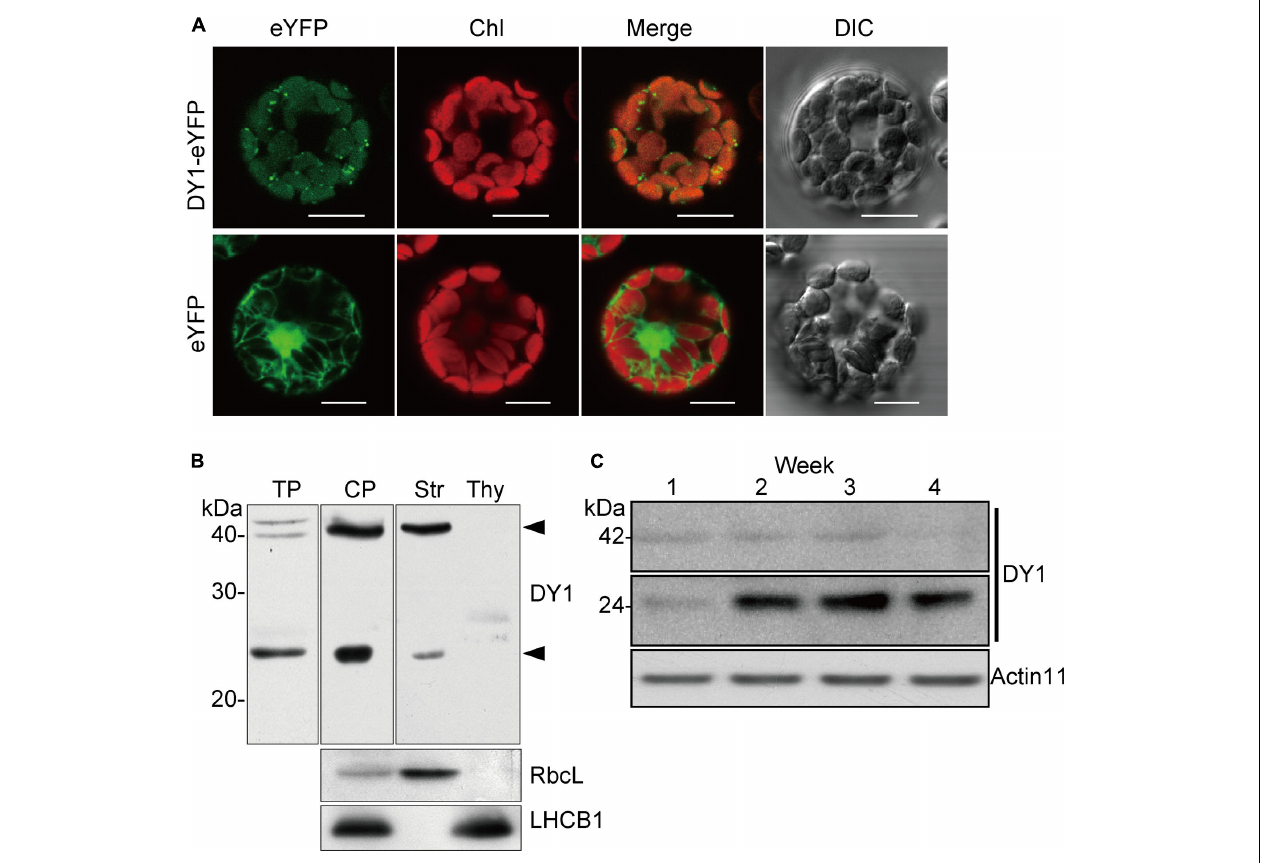
FIGURE 7 | DY1 is a chloroplast stroma protein. (A) Subcellular localization of DY1 in chloroplast. Protoplasts transformed with pA7-eYFP-DY1 were observed under a FLUOVIEW FV1000 Laser Confocal Microscopy System (Olympus) (Bars = 20 µ m). (B) Western blot analysis demonstrating the stroma localization of DY1. Purified chloroplast were sub-fractionated into the stroma and thylakoid membrane fractions, separated by SDS–PAGE, blotting and probed with the antiserum against DY1. LHCB1 and RbcL were probed as controls. The bands of processed and mature forms of DY1 at 42 and 24 kDa, respectively, are indicated. TP, plant total protein; CP, intact chloroplast protein; Str, stroma fraction; Thy, thylakoid membrane fraction. (C) Western blot analysis of the accumulation of the 24 kDa form of DY1 during leaf development. The numbers above each lane indicate the growth stages in